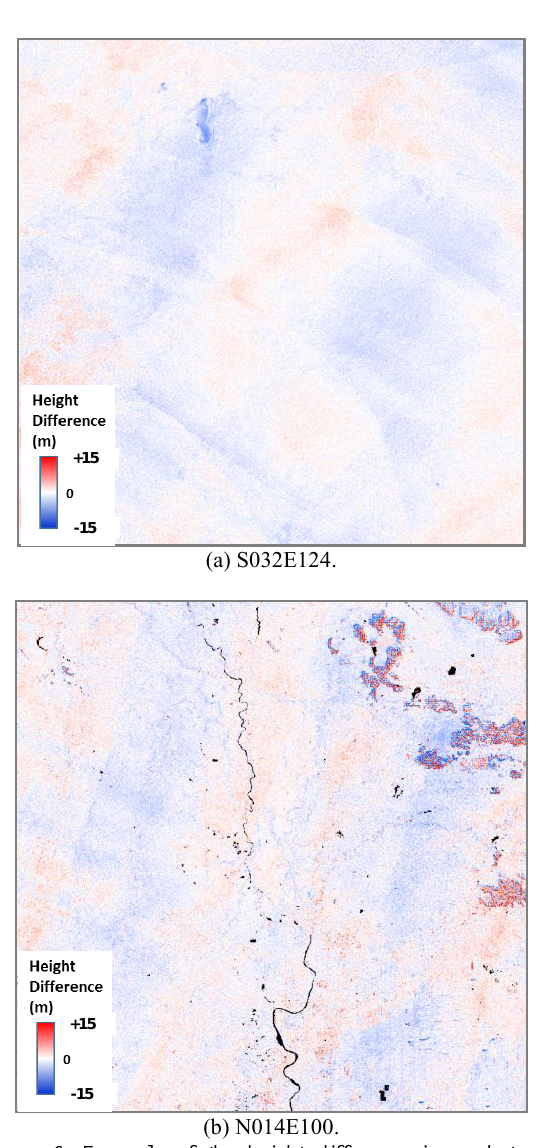
Figure 6. Example of the height difference image between AW3D30 Ave DSM (30 m mesh) and SRTM-3 v.3 (90 m mesh).